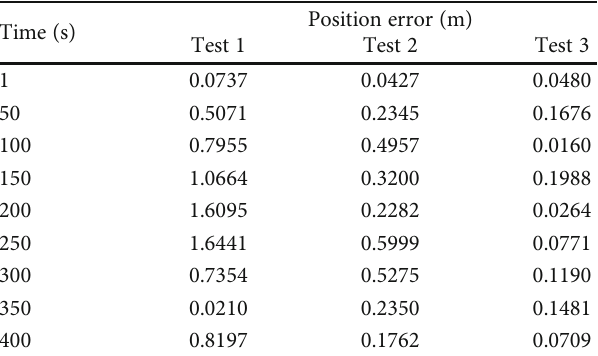
Figure 14: Improved algorithm control results for experiment 3 environment. Table 5: Improved algorithm control error statistics for experiment 3